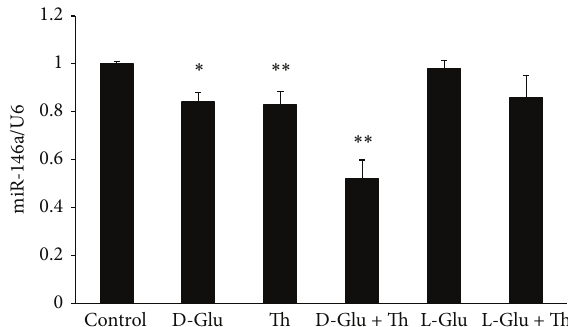
Figure 4: HG/thrombin downregulated miR-146a expression in HAECs. miR-146a expression was measured by real-time PCR. HG/thrombin stimulation for 5 h decreased miR-146a expression to 58% of that in the control. The bars represent the means ± SEM from 5 experiments. ∗ 𝑃 < 0.05 and ∗∗ 𝑃 < 0.01 , as compared with the control. miR levels are expressed as the ratio of RNU6B